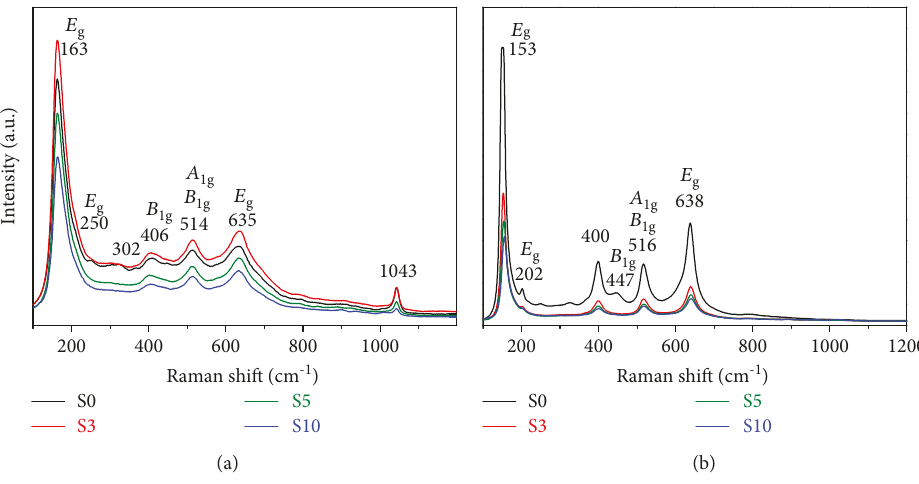
Figure 4: Raman shift of S0, S3, S5, and S10 (a) and S0C, S3C, S5C, and S10C